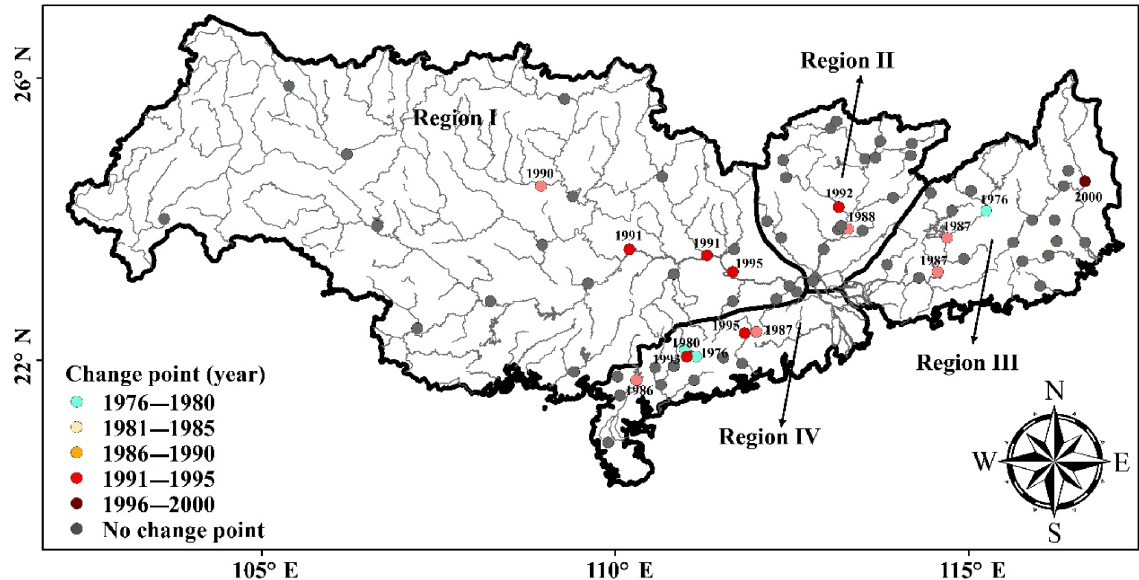
Figure 3. Spatial distribution of change points using the Pettitt test for peak flood flow changes.